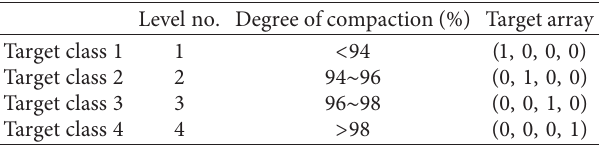
Table 4: Target class and compaction